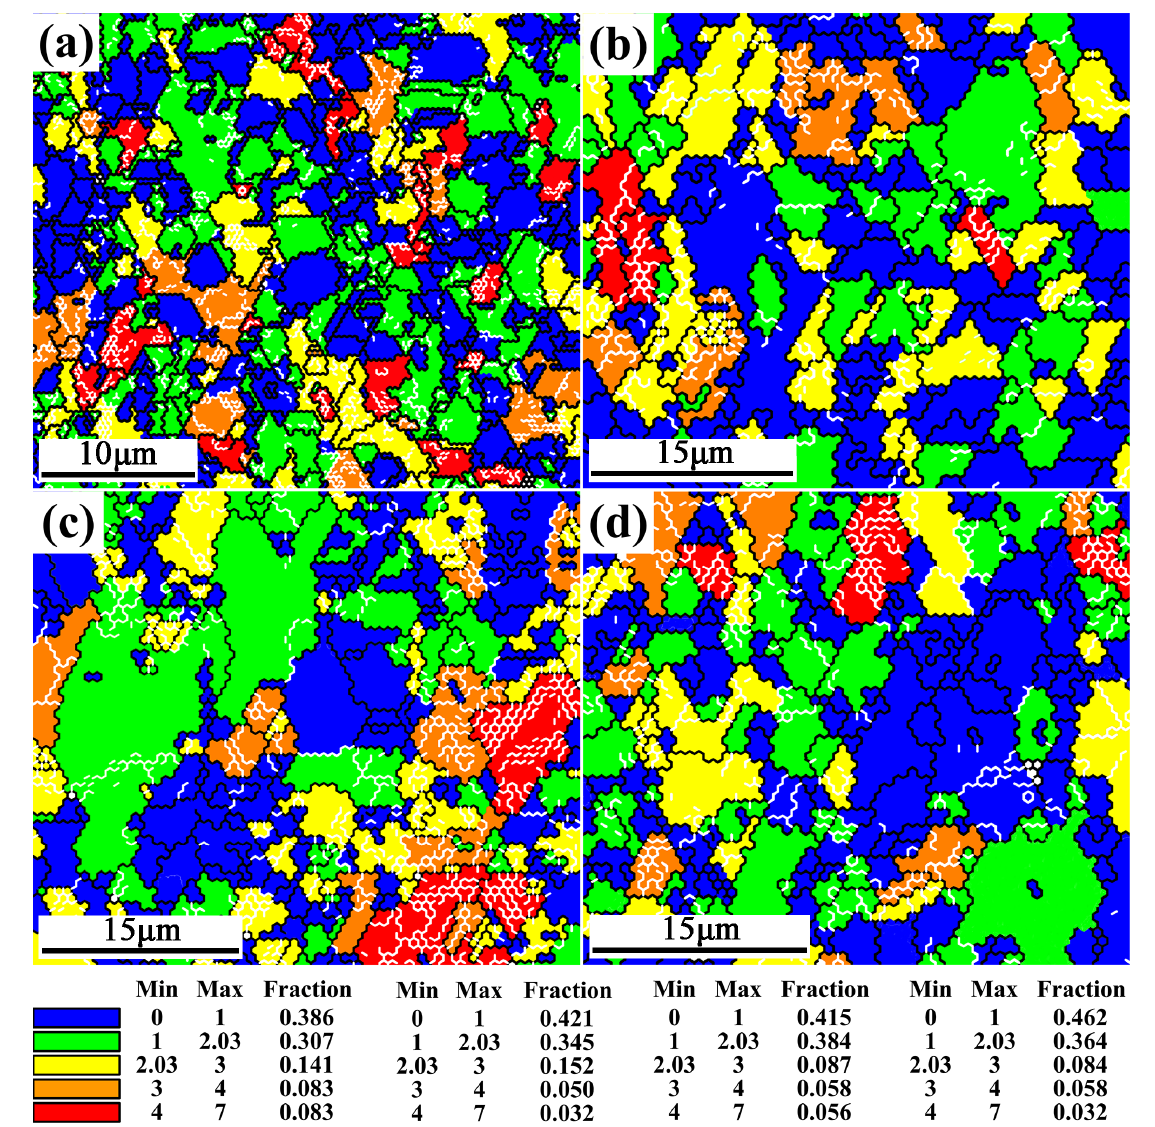
Figure 3. GOS analysis of the initial and heat-treated TiAl alloy: ( a ) initial TiAl alloy [13], ( b ) HT1, ( c ) HT3 and ( d ) HT5.